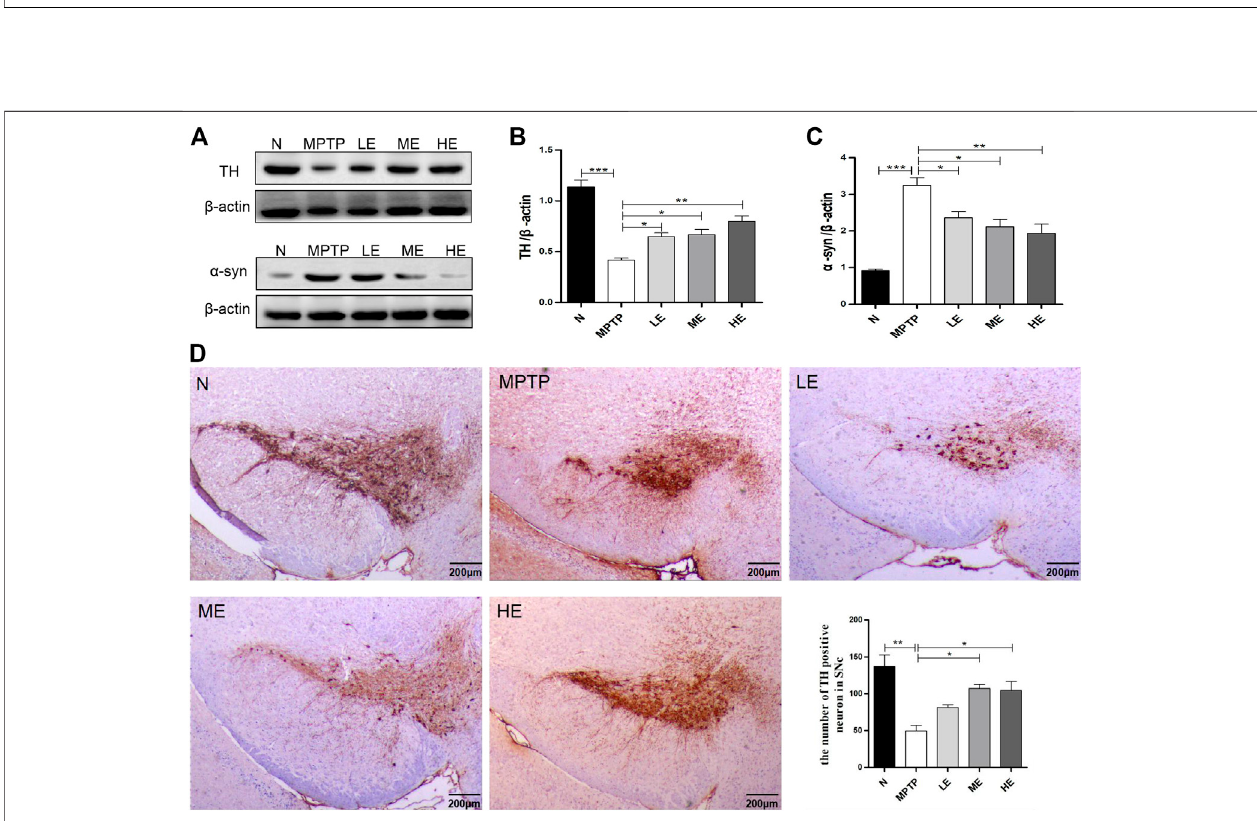
FIGURE 2 | ECH protected DA neurons and decreased the expression of α -synuclein in substantia nigra (SN) ofMPTP-induced mice. (A) Expression ofTH and α - synuclein of mice in different groups. (B) Data analysis of TH expression. (C) Data analysis of α -synuclein expression. (D) Representative microphotographs of dopaminergic neurons stained for TH. Scale bars: 200 μ m. Values are presented as the mean ± SEM. * p < 0.05, ** p < 0.01, *** p < 0.001.